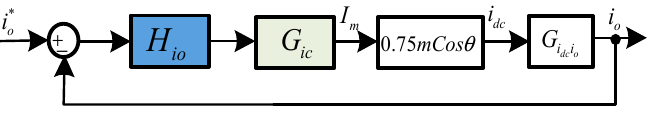
Figure 8. Outer current control loop diagram for the d -axis.